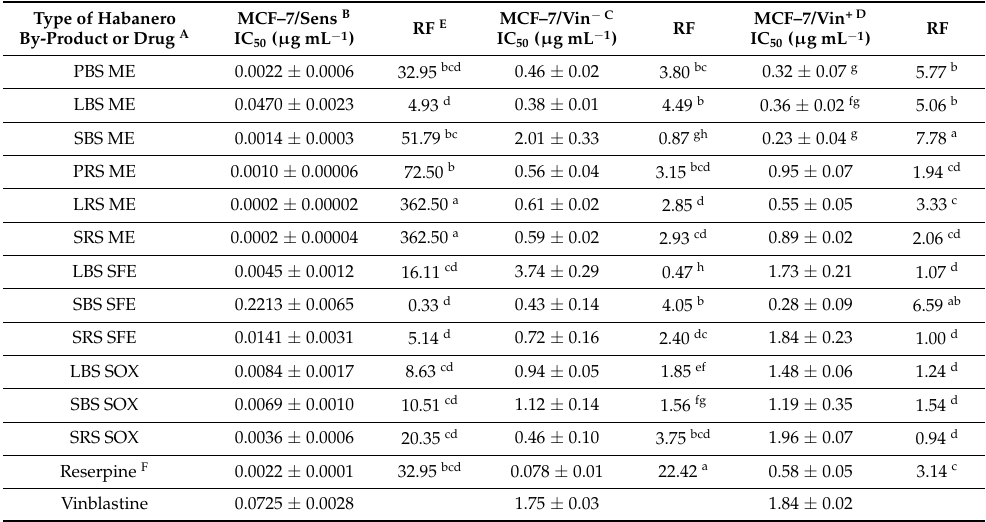
Table 1. Modulating effect of the cytotoxic activity of habanero by-product extracts on human cell lines of breast cancer, parental and resistant to vinblastine.